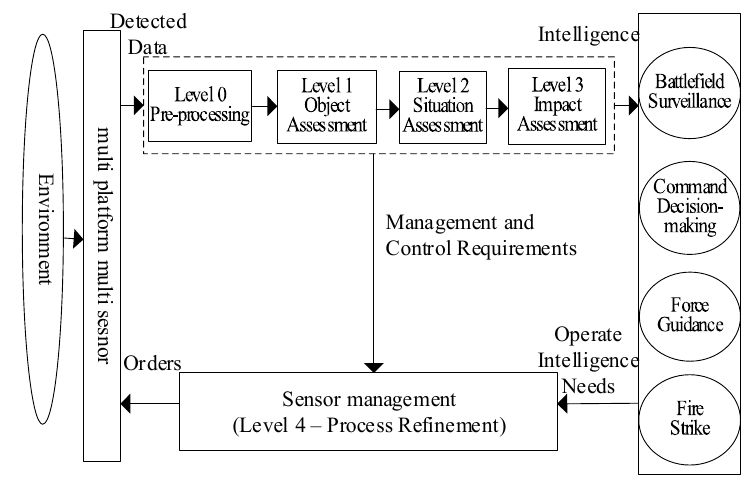
Figure 1. Sensor management constitutes information fusion feedback control.